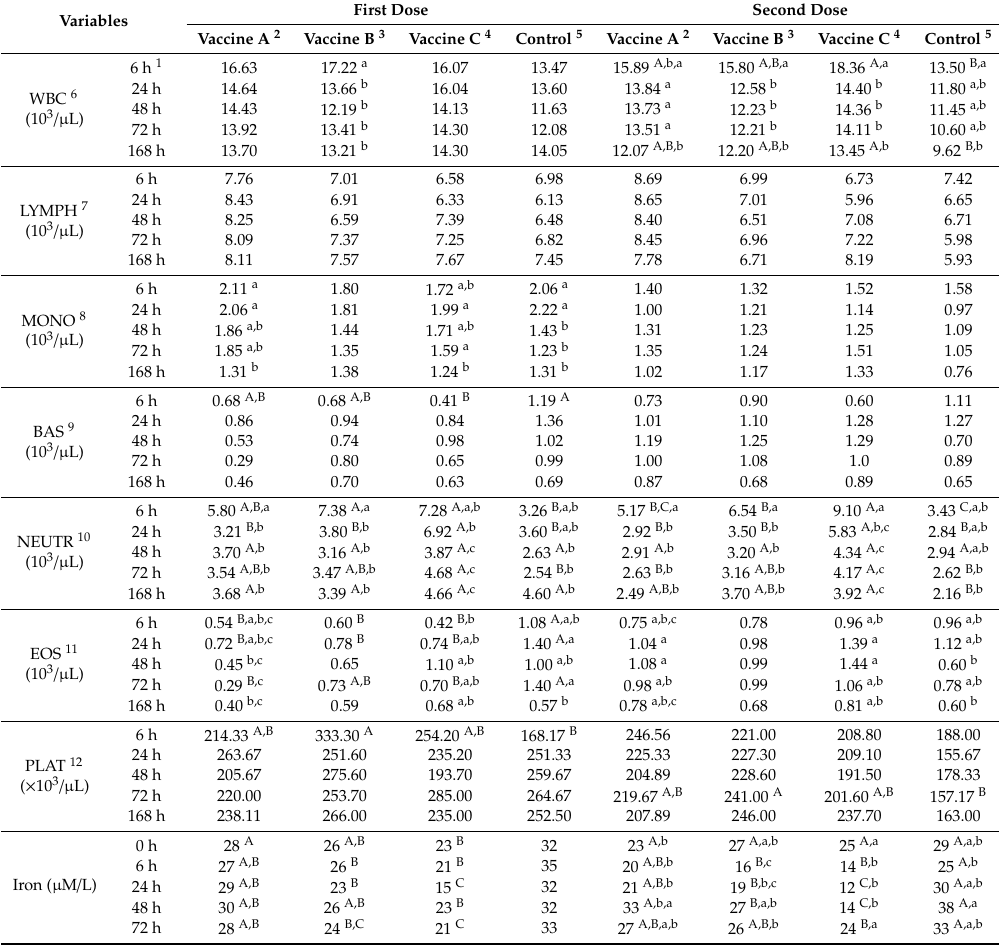
Table A3. Clinical pathology evaluated by absolute mean values (10 3 / µ L) obtained in the counts of leukocytes, platelets and serum iron of animals vaccinated with vaccines against BVDV and BHV-1 with di ff erent commercial